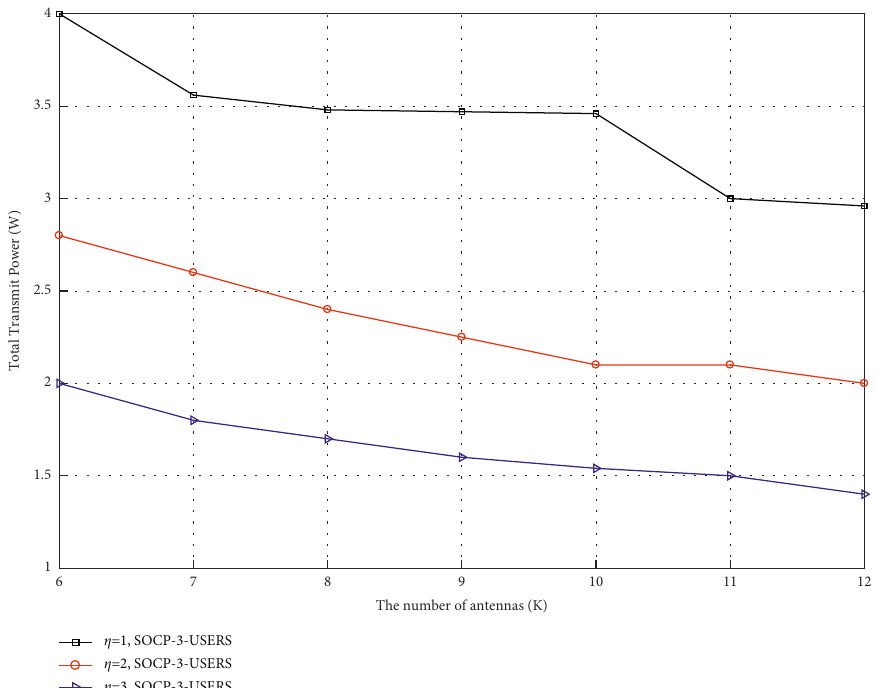
Algorithm 2, OMA Without Information Enhancement And Interference Elimination Algorithm 2, NOMA Without Information Enhancement And Interference Elimination Algorithm 2, NOMA With Information Enhancement, And Without Interference Elimination Algorithm 2, NOMA With Information Enhancement And Interference Elimination Figure 5: The optimal total transmission power versus the number of transmit antennas, with c � 1 and ζ � 0.